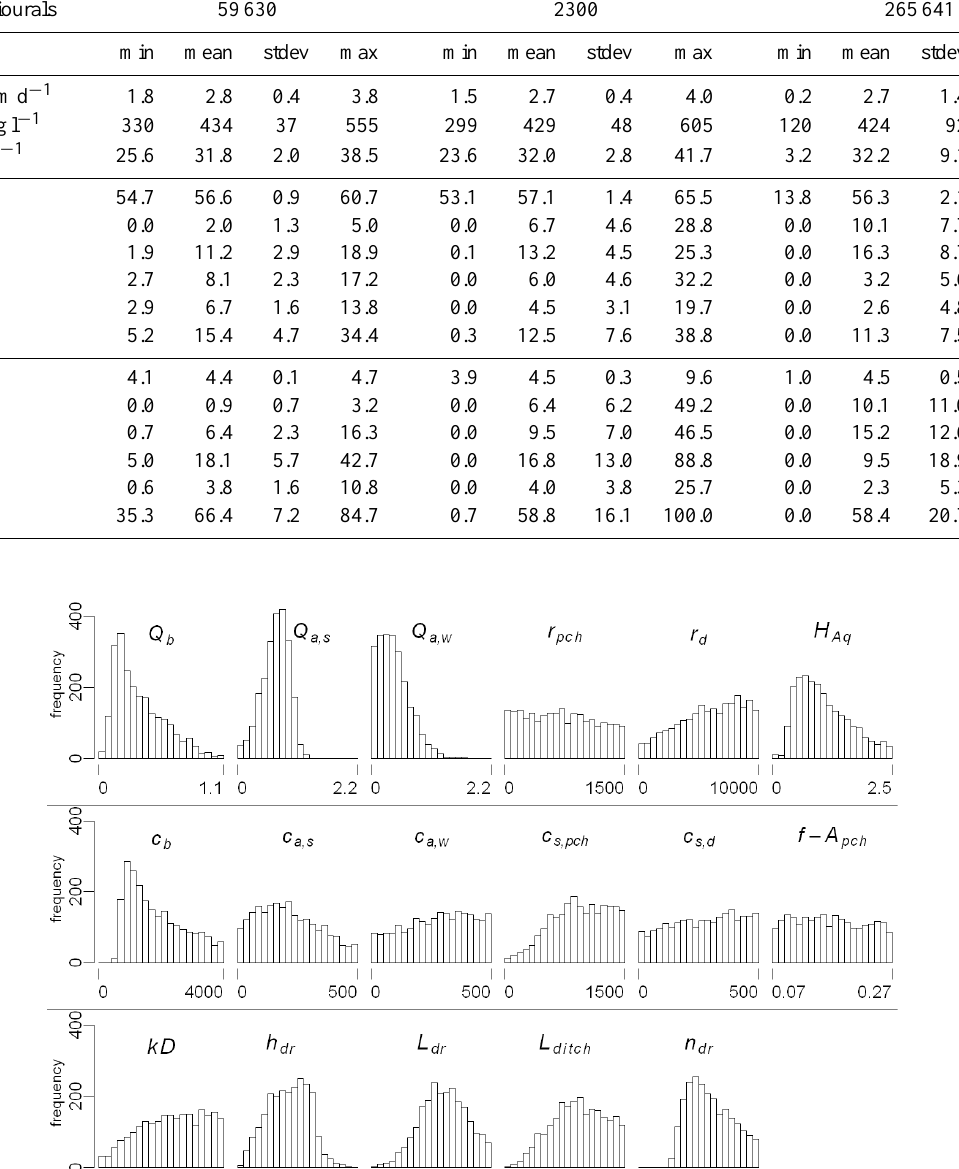
Hydrol. Earth Syst. Sci., 15, 2101–2117,